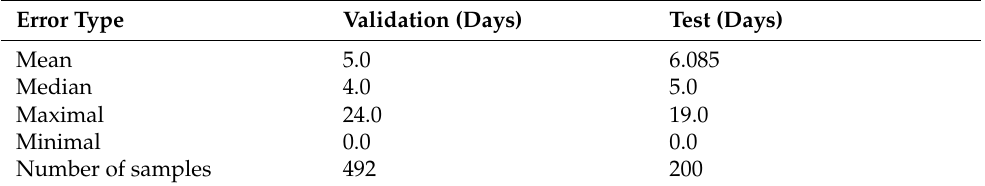
Figure 4. Comparison of the model solutions with data of the training data set ( A ) and the model predictions with the data of the validation data set ( B ); r is a Pearson correlation coefficient. The slope of the diagonal line is 1. Table 1. Error estimates for validation and test. Mean, median, maximal and minimal difference in the number of days to flowering between the model solution and data.